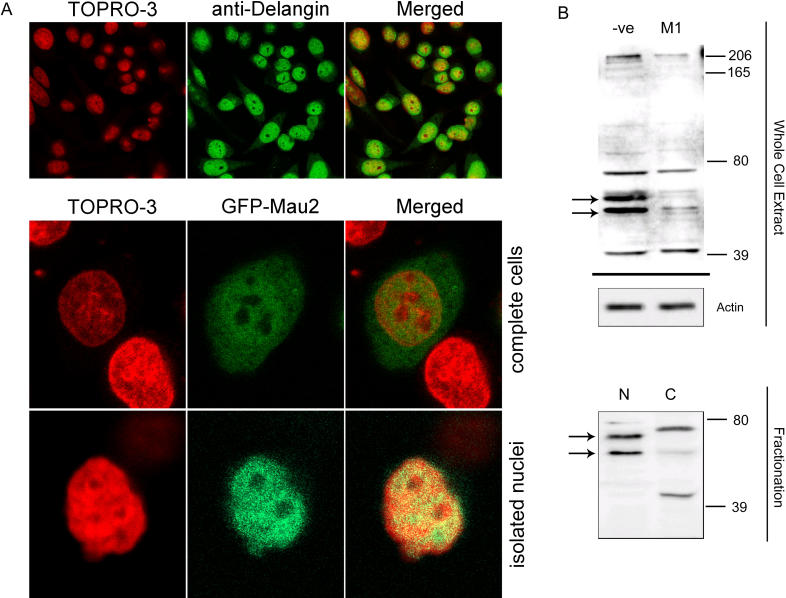
Human MAU-2 and Delangin Are Nuclear Proteins(A) Confocal microscopy studies on HeLa cells. The nuclear localization of delangin is illustrated in the top panels using a FITC-labeled secondary antibody detecting monoclonal rat anti-human delangin (see
Materials and Methods). Panel on the right shows merging of DNA image (left panel, red) and delangin staining (center panel, green). Expression of a GFP-human MAU-2 fusion protein revealed by confocal fluorescence microscopy of transiently transfected HeLa cells is shown in the center and bottom panels. The fusion protein appears present in both the nucleus and the cytoplasm, sometimes with a strong nuclear localization, as shown in the center panels, but in other cells cytoplasmic expression predominated. Bottom panels show retention of the GFP-human MAU-2 protein in nuclei isolated from transiently transfected HeLa cells and subsequently extracted in 0.5% Triton-X. Center and bottom panels show DNA staining with TOPRO3 (left), the GFP fluorescence signal (center), and merged images (right).
(B) Nuclear location for epitopes specific to human MAU-2. Top panel: Antisera against human MAU-2 cross reacted with four major bands in whole cell extracts from HeLa cells that had been treated with the negative (-ve) control siRNA oligonucleotide. The two bands indicated by the arrows were severely reduced in intensity (by ˜90%) when the same antisera was used to blot whole cell extracts from HeLa cells that had been subjected to human MAU-2 siRNA, using the M1 siRNA oligonucleotide (see
Materials and Methods). Beta actin is shown as loading control. Bottom panel: HeLa cells were separated into cytoplasmic (C) and nuclear (N) fractions (see
Materials and Methods). When these fractions were immunoblotted with human MAU-2 antisera, the bands specific to human MAU-2 were almost exclusively detected in the nuclear fraction, while the background bands appeared to be cytoplasmic.